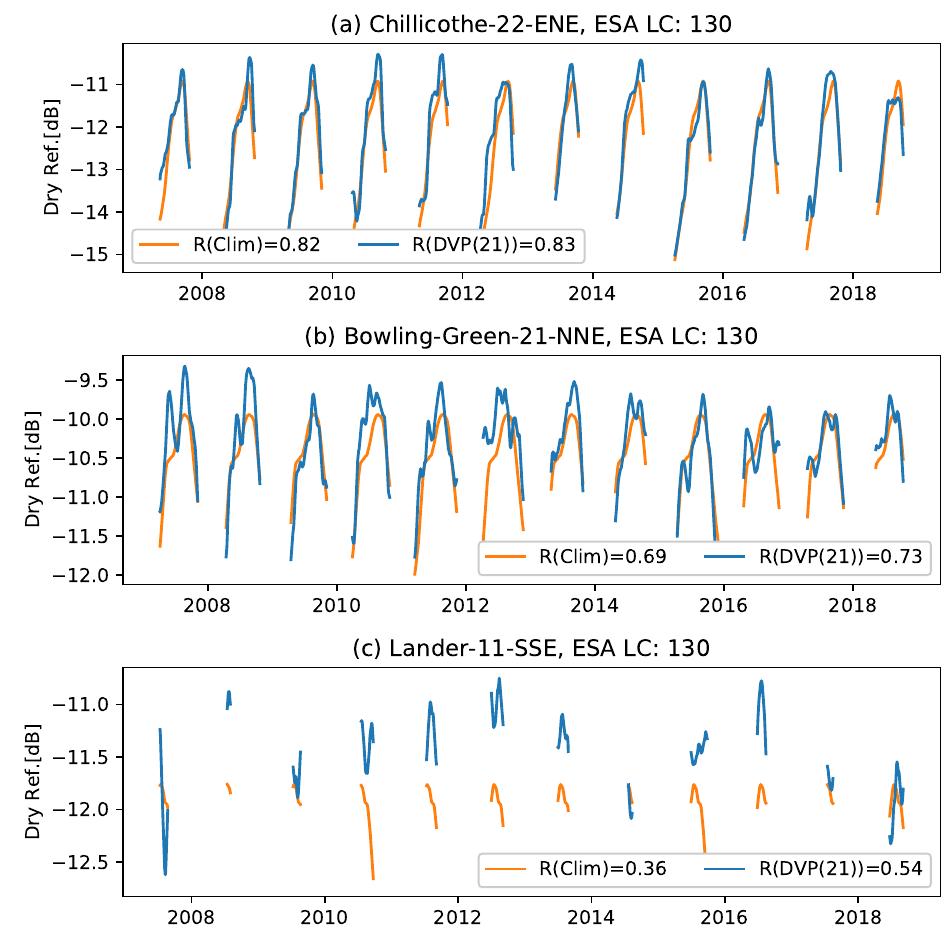
Figure 8. Comparison of the dry reference estimated using vegetation parameters from climatology and dynamic vegetation parameters at three stations that indicate modest to significant improvement in R when DVPs are used. Results are presented for ( a ) Chillecothe ( b ) Bowling Green and ( c ) Lander